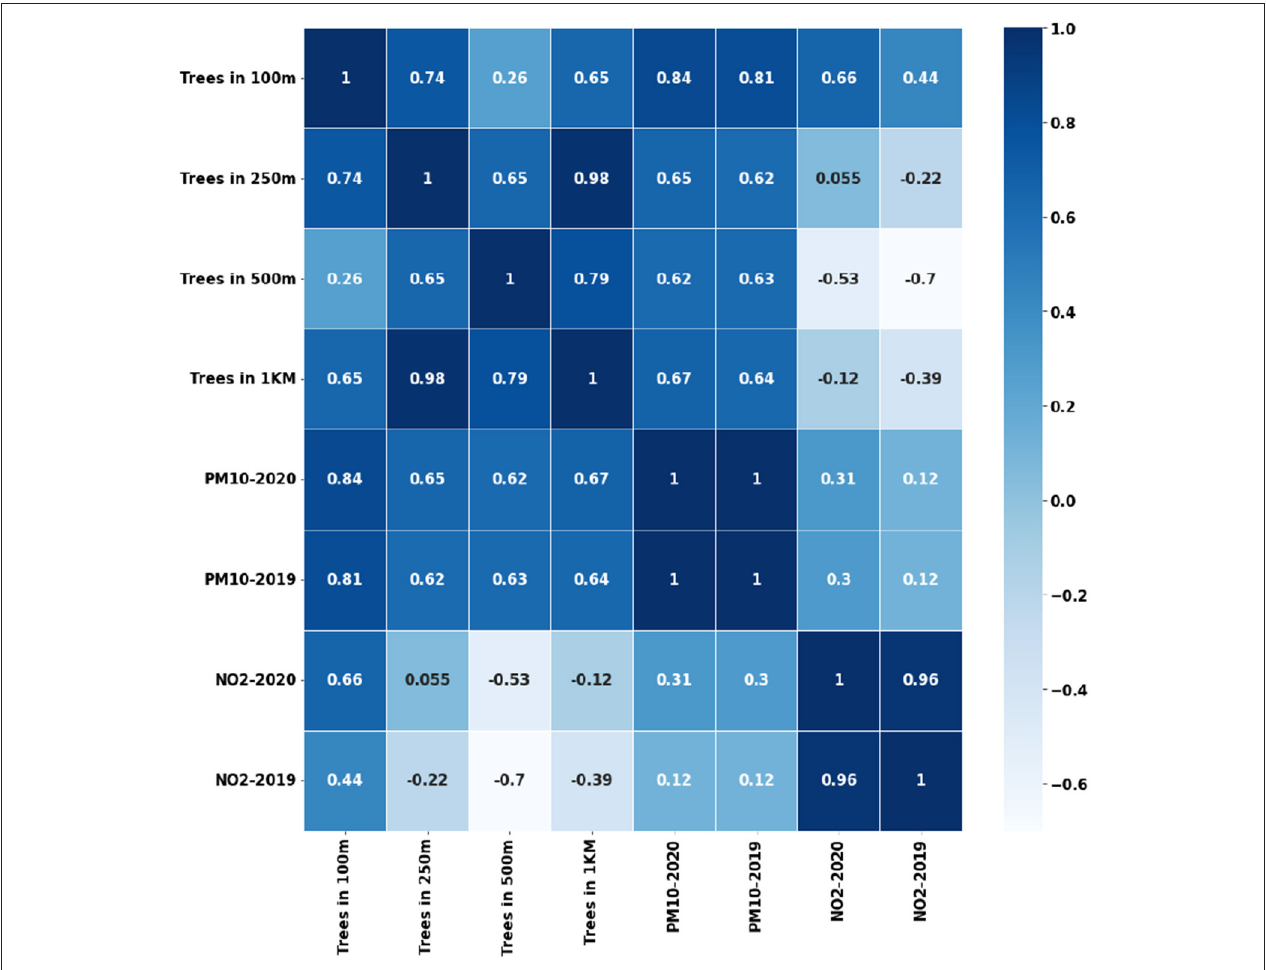
FIGURE 9 | Correlation between vegetation and pollutants ( PM 10 and NO 2